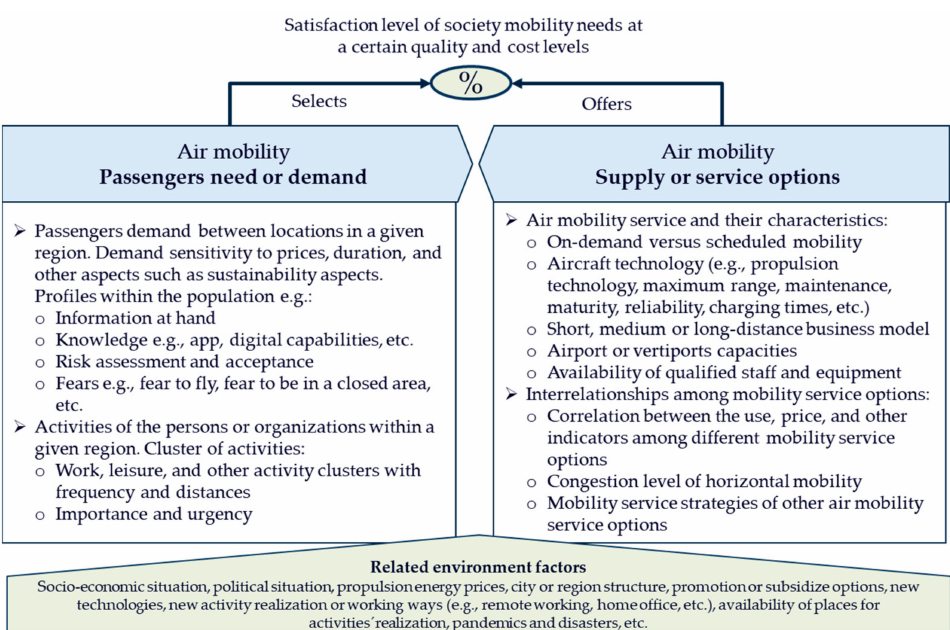
Figure 3. Conceptual framework for Air Mobility Needs and Supply